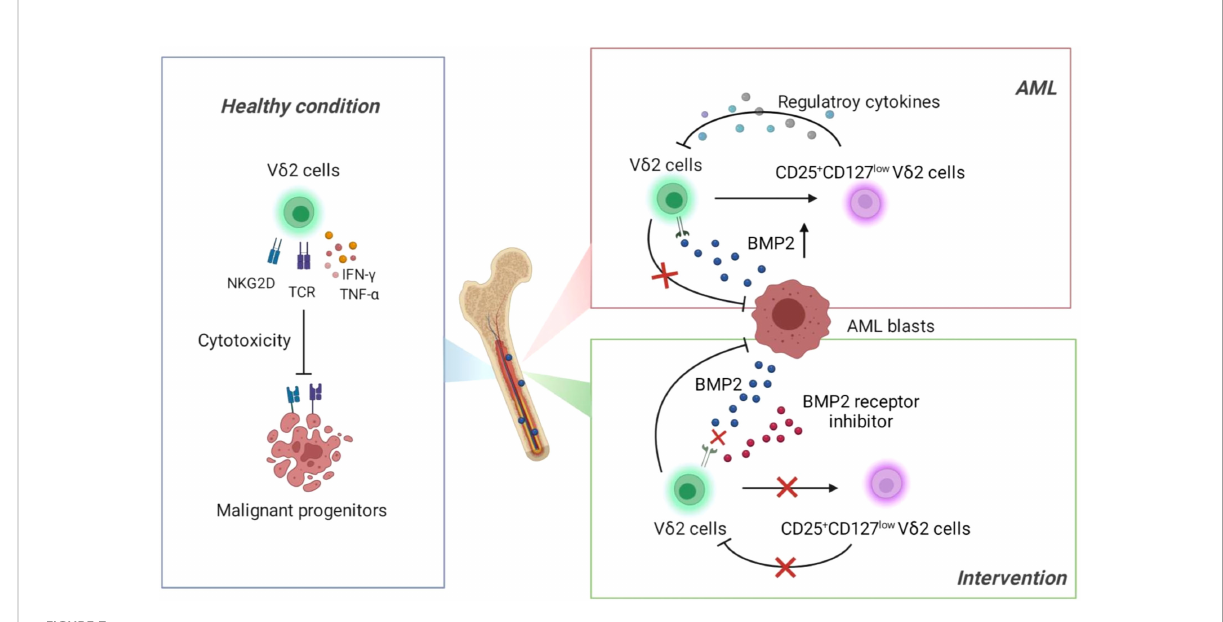
FIGURE 7 Schematic of main conclusions from this